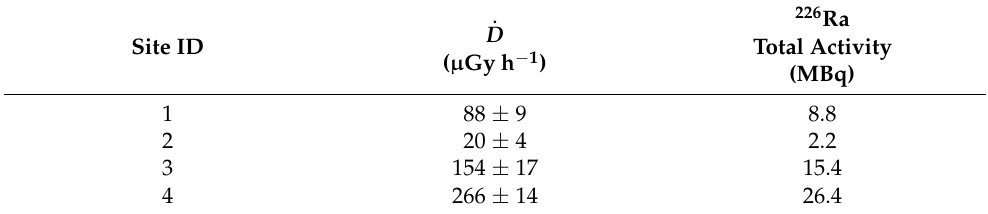
Table 2. The absorbed dose rate measured at contact and the total activity of 226 Ra in the “hot spots”